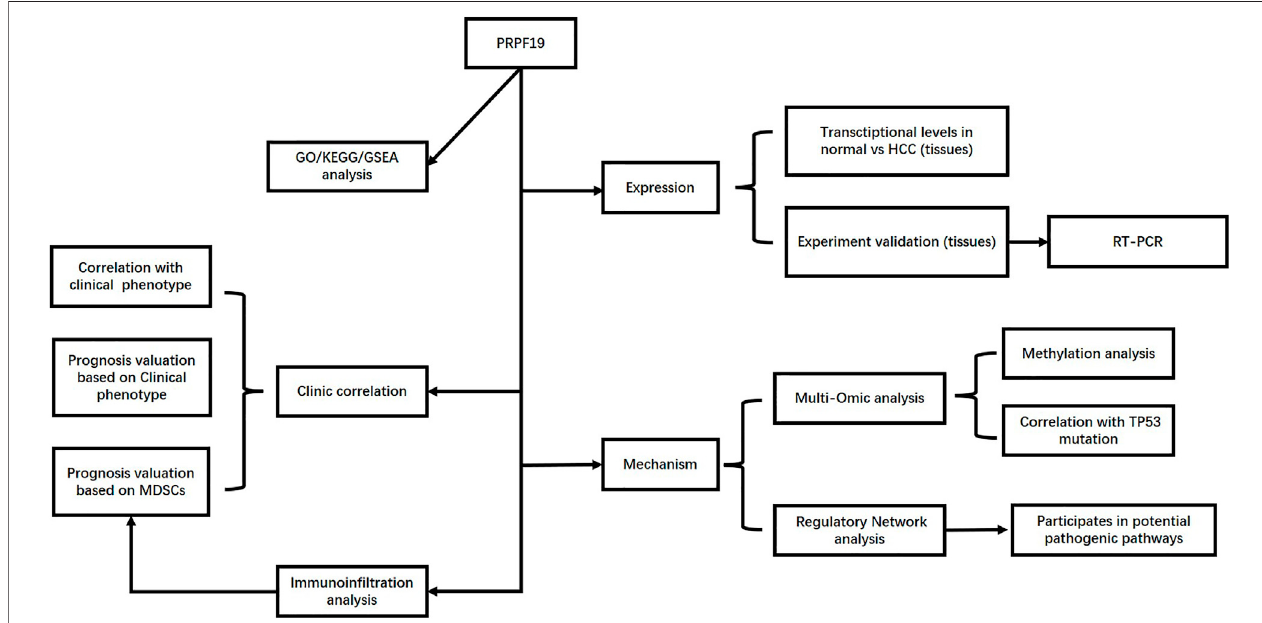
FIGURE 1 | Flow diagram of data collection and method implementation in this